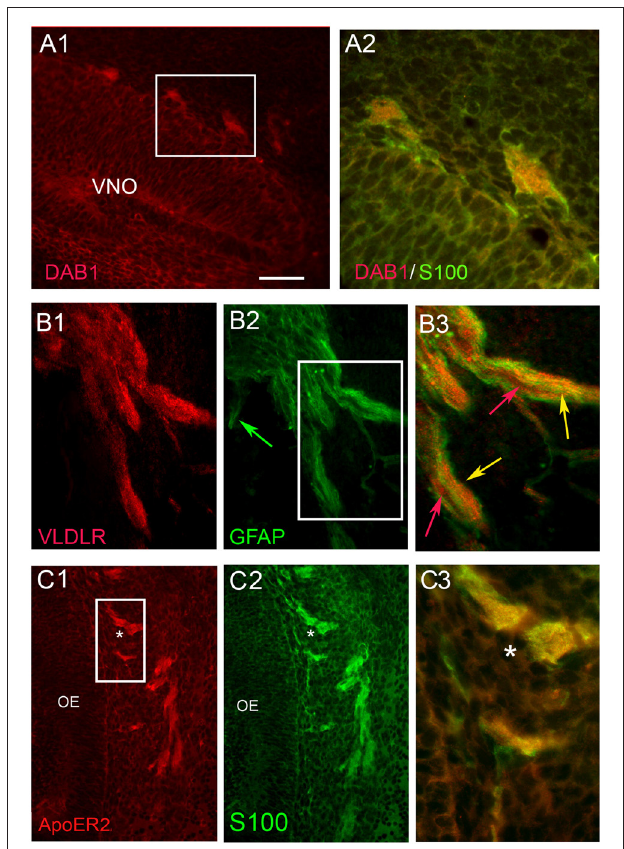
FIGURE 4 | OECs express Dab1, ApoER2 and VLDLR during mouse embryonic development. Double label experiments were performed at stages E12.5-E14.5. OECs, identified by S100 or GFAP (green), expressed Dab1 (A) , VLDLR (B) and ApoER2 (C) . Scale Bar in (A1) = 200 µ m in (A1,B1,2,C1,2) ; 100 µ m in (B3) and 50 µ m in (A2,C3) . Boxed areas in (A1,B2) show locations of (A2,B3) respectively. In row (B) , red and green arrows show examples of elements expressing single label, while yellow arrows indicate examples of double-labeled elements. Asterisk in (C1–3) reference same location. OE, olfactory epithelium.